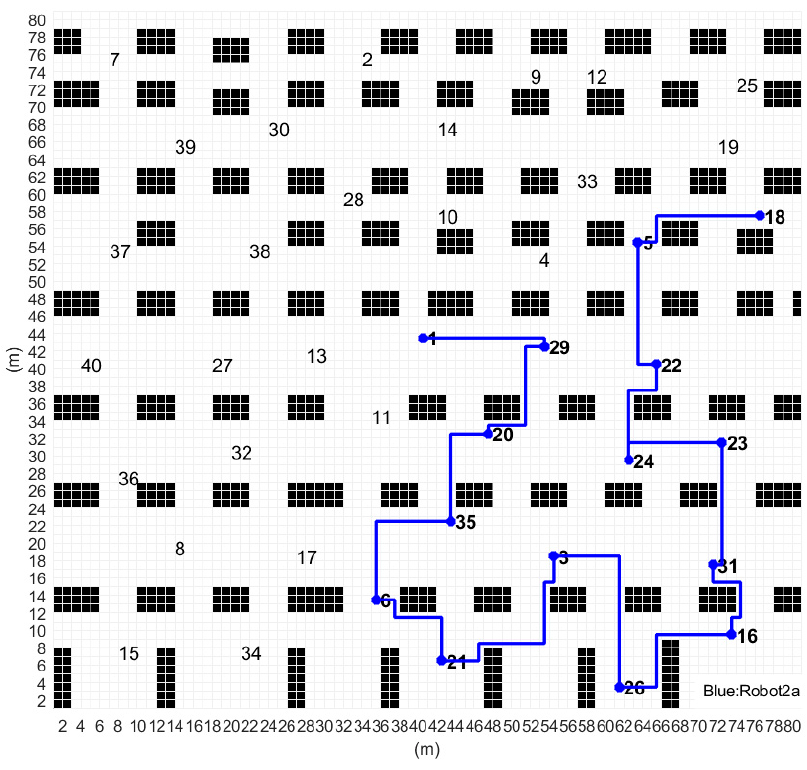
Table 4. Path planning operation parameters of A* algorithm from Experiment 4.